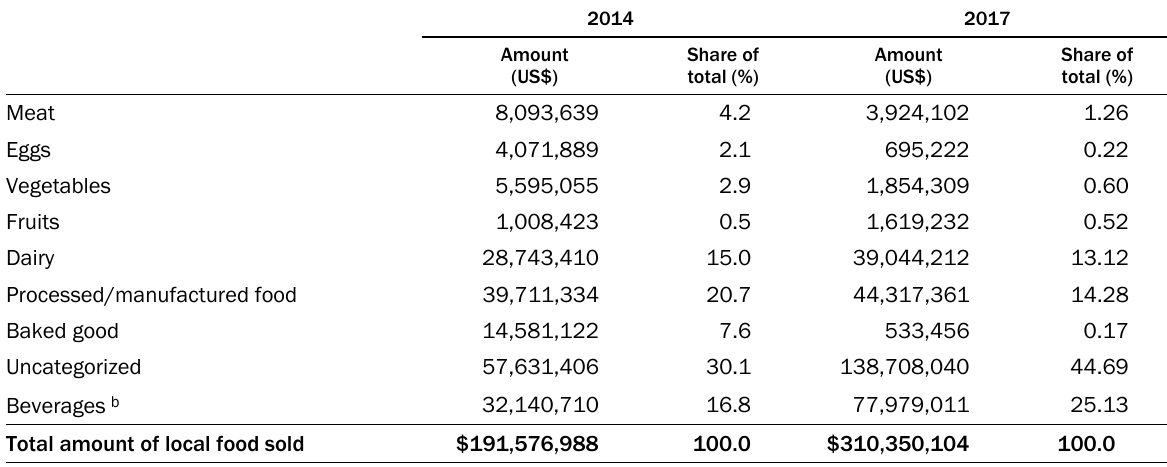
Table 3. Local Food Sales in Vermont, 2014–2017, by Food Category (Adjusted for